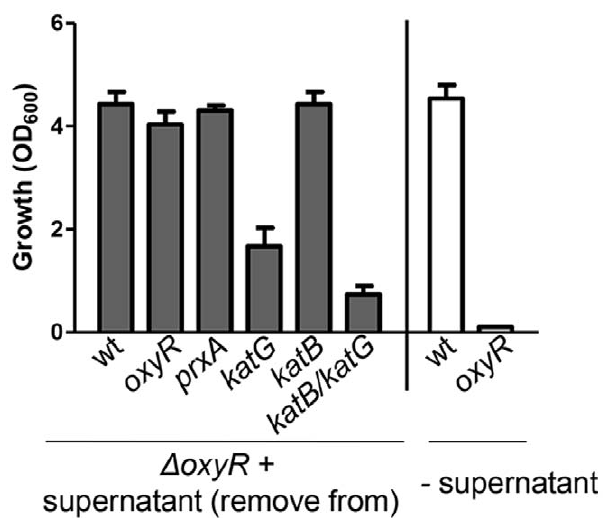
Figure 3. The effect of culture supernatants from different strains on oxyR growth. Overnight cultures of oxyR mutants were inoculated 1:1000 into fresh LB with 1/10 (v/v) cell-free supernatants prepared from strains indicated and shaken at 37 u C. OD 600 was measured after 8-hr incubation. As controls, overnight cultures of wildtype and oxyR mutants were inoculated 1:1000 into fresh LB without any supernatants (white bars). Data are mean and s.d. of three independent